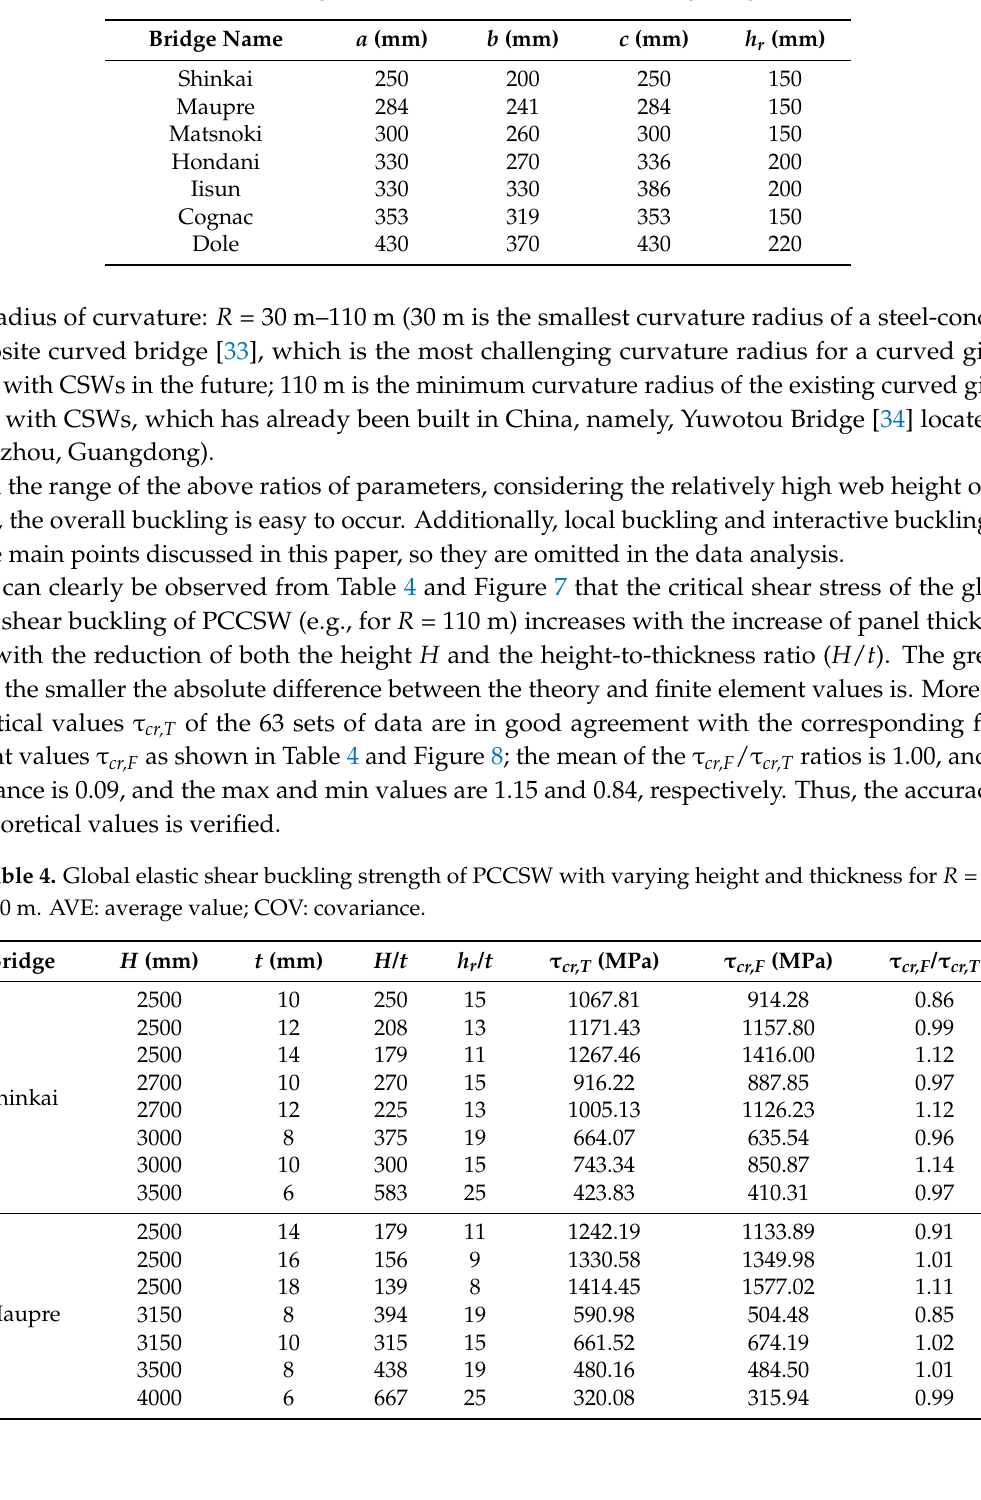
Table 3. Corrugation dimension of CSWs for existing bridges.